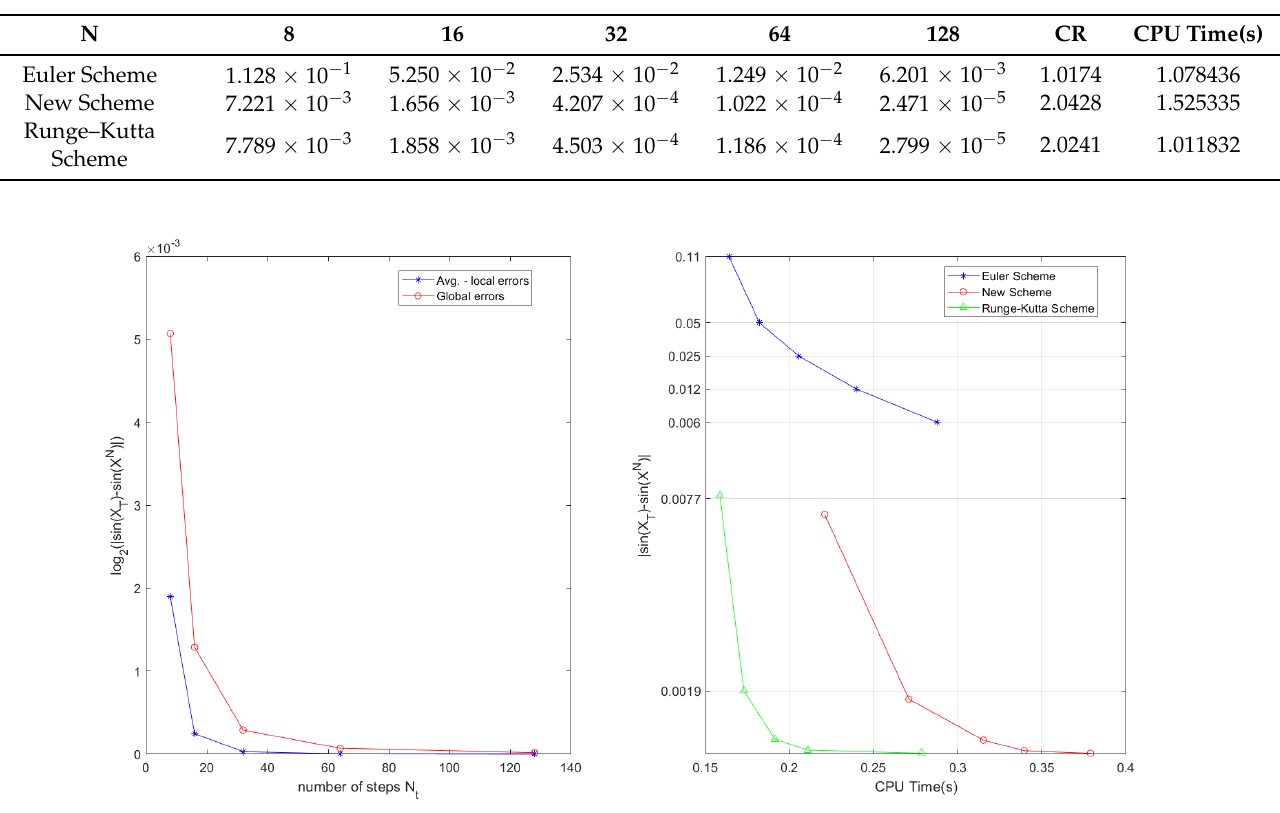
Figure 2. ( Left ) The global error and Avg.local error of Scheme 1 for Example 1. ( Right ) The correlations for global errors and CPU Time of all